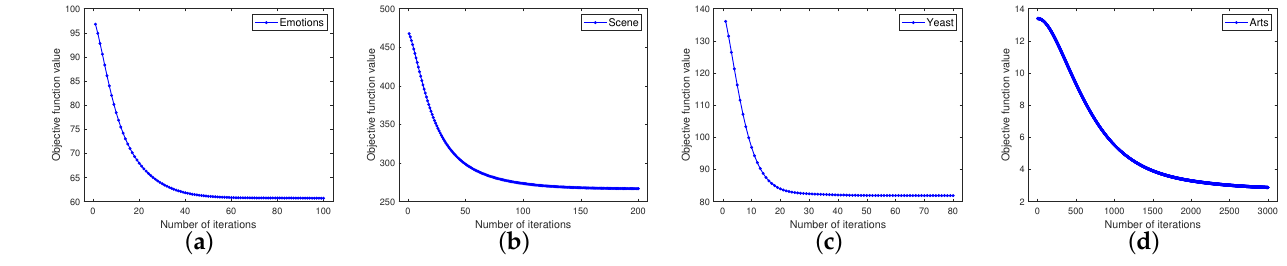
Figure 10. Convergence analysis of proposed method on four data sets. ( a ) Emotions. ( b ) Scene. ( c ) Yeast. ( d ) Arts.